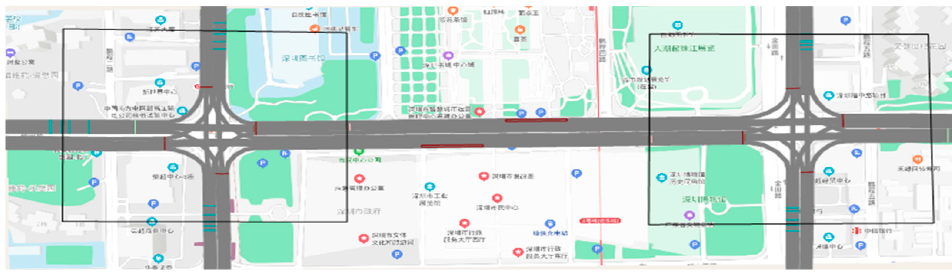
Figure 3. Simulation model of coordinated control of arterial road.